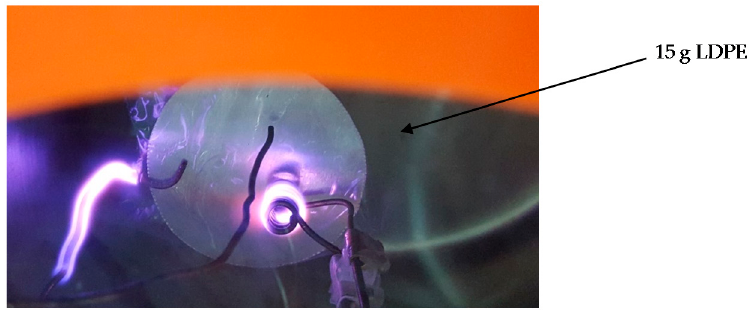
Figure 10. DC thermal plasma on a 15 g LDPE.